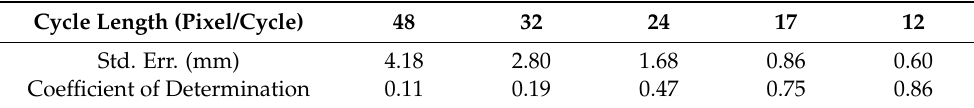
Table 1. Standard errors of regression at each cycle